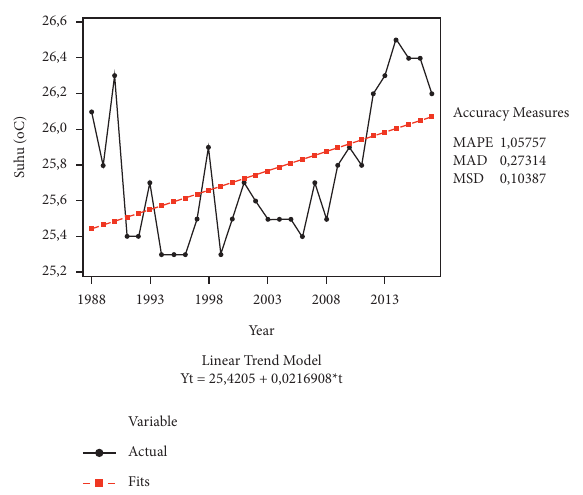
Figure 3: Temperature trend ( ° C) at research locations over the last 30 years (1988–2017) based on the linear trend model.